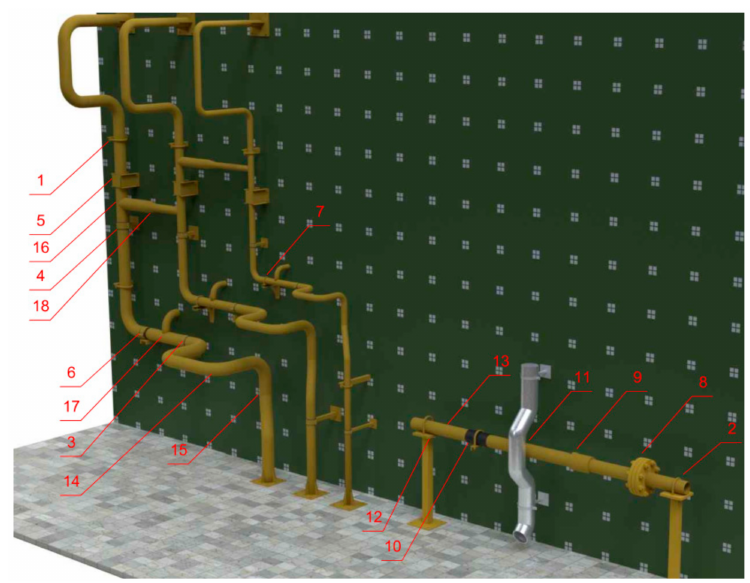
Figure 3. Construction of the test